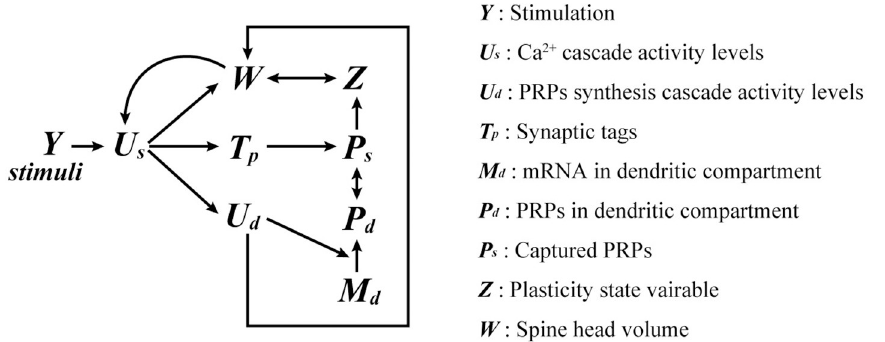
Fig 1. A schematic diagram of our model. The relationships between the variables formulated in Eqs (1)–(8). Arrows mean that the variable following the endpoint of the arrow depends on the variable preceding the starting point.